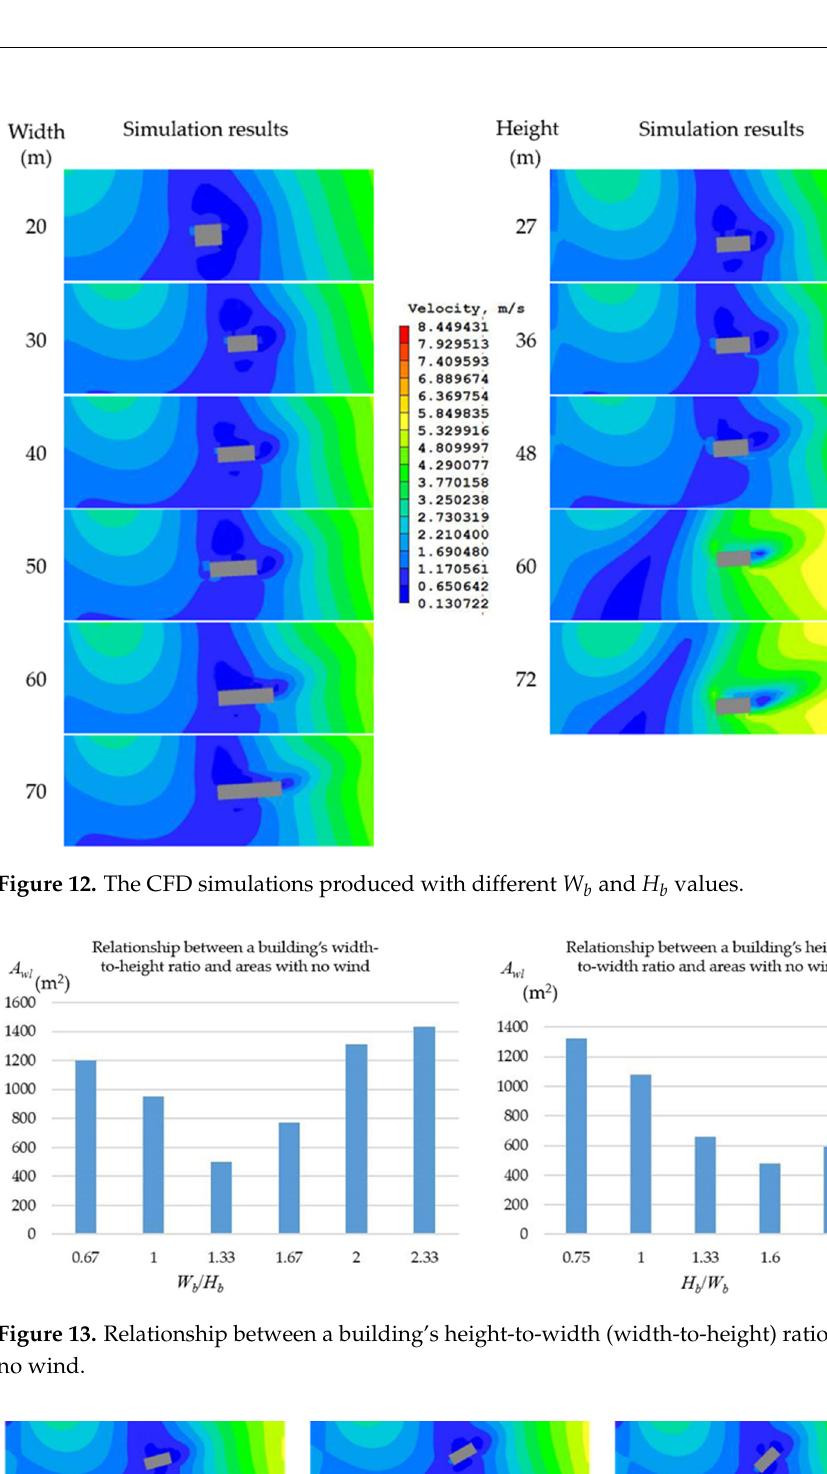
Figure 13. Relationship between a building’s height-to-width (width-to-height) ratio and areas with no wind.